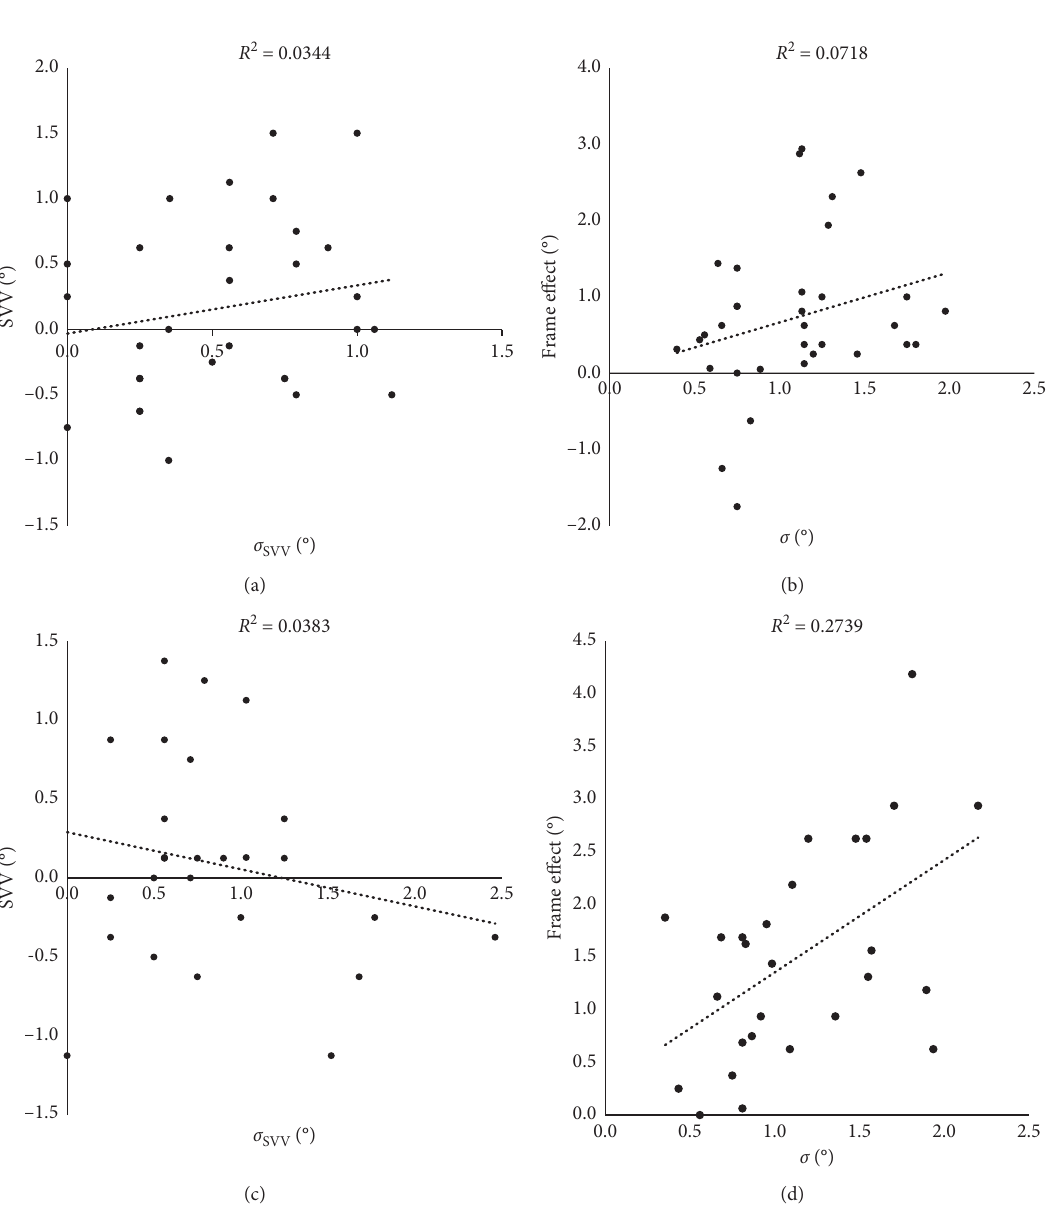
Figure 2: Associations between intraindividual tilt variability and tilt magnitude or frame effect in young adults (a, b) and older adults (c, d). σ SVV and σ represent variability in the no-frame and oriented-frame conditions,